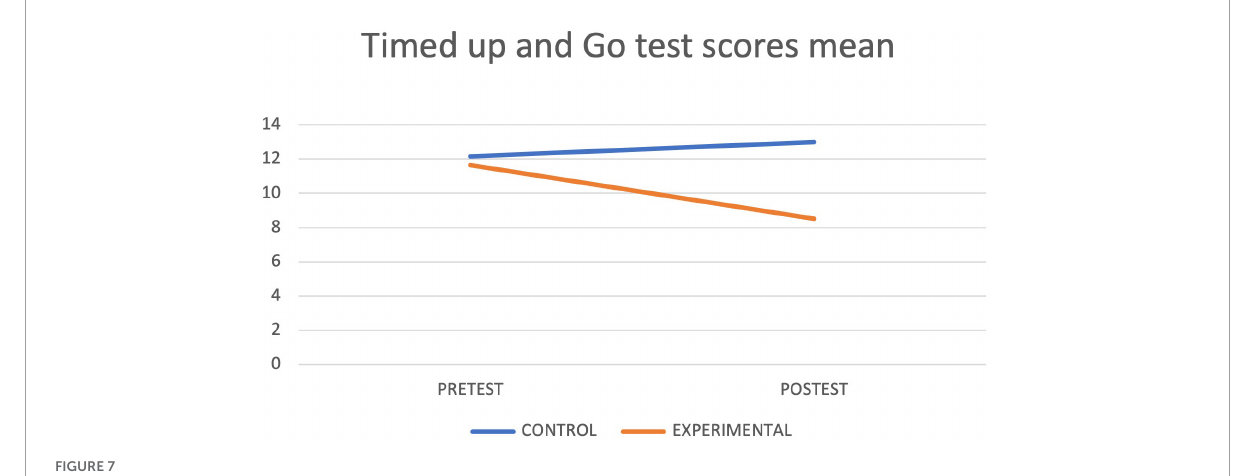
FIGURE7 Timed up and go test lineal model.